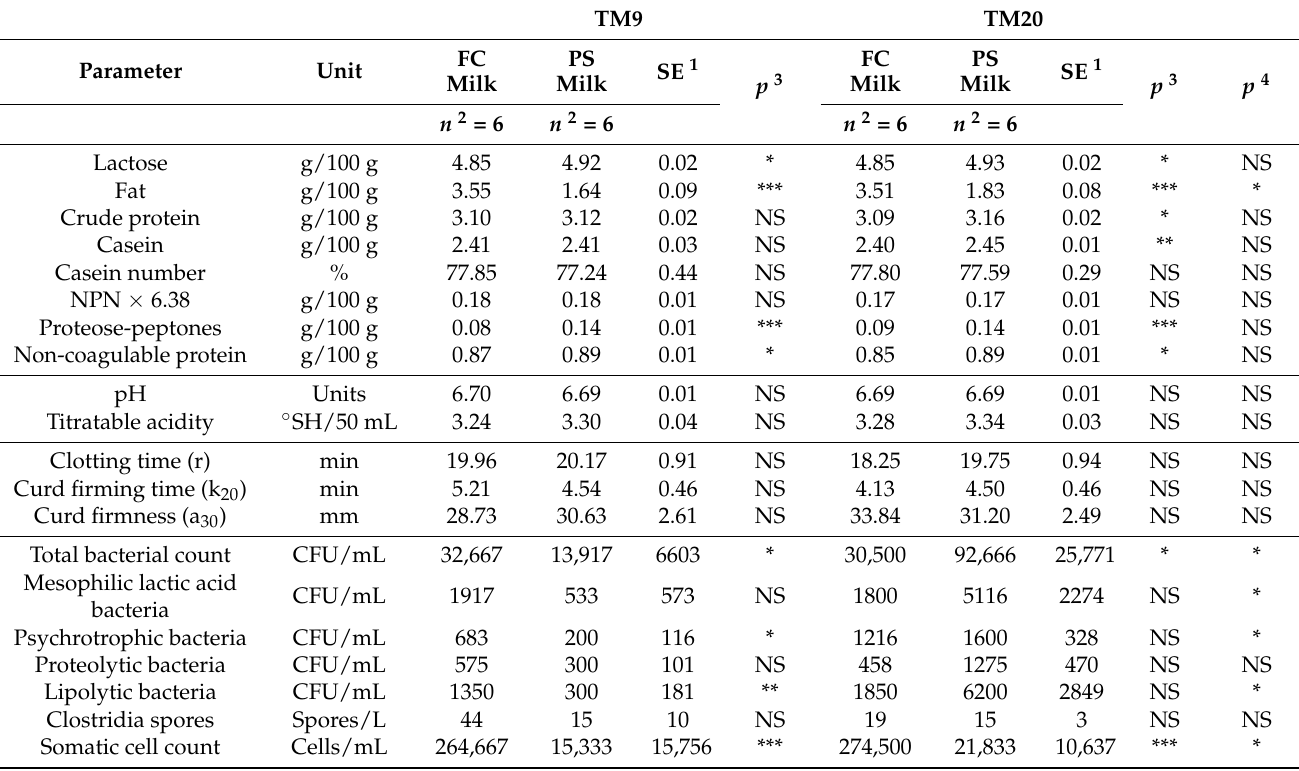
Table 1. Least square mean values of chemical composition, physicochemical properties, and microbiological parameters of full cream milk (FC) and partially skimmed milk (PS) obtained from bulk milk kept at farm at 9 ◦ C (TM9) and at 20 ◦ C